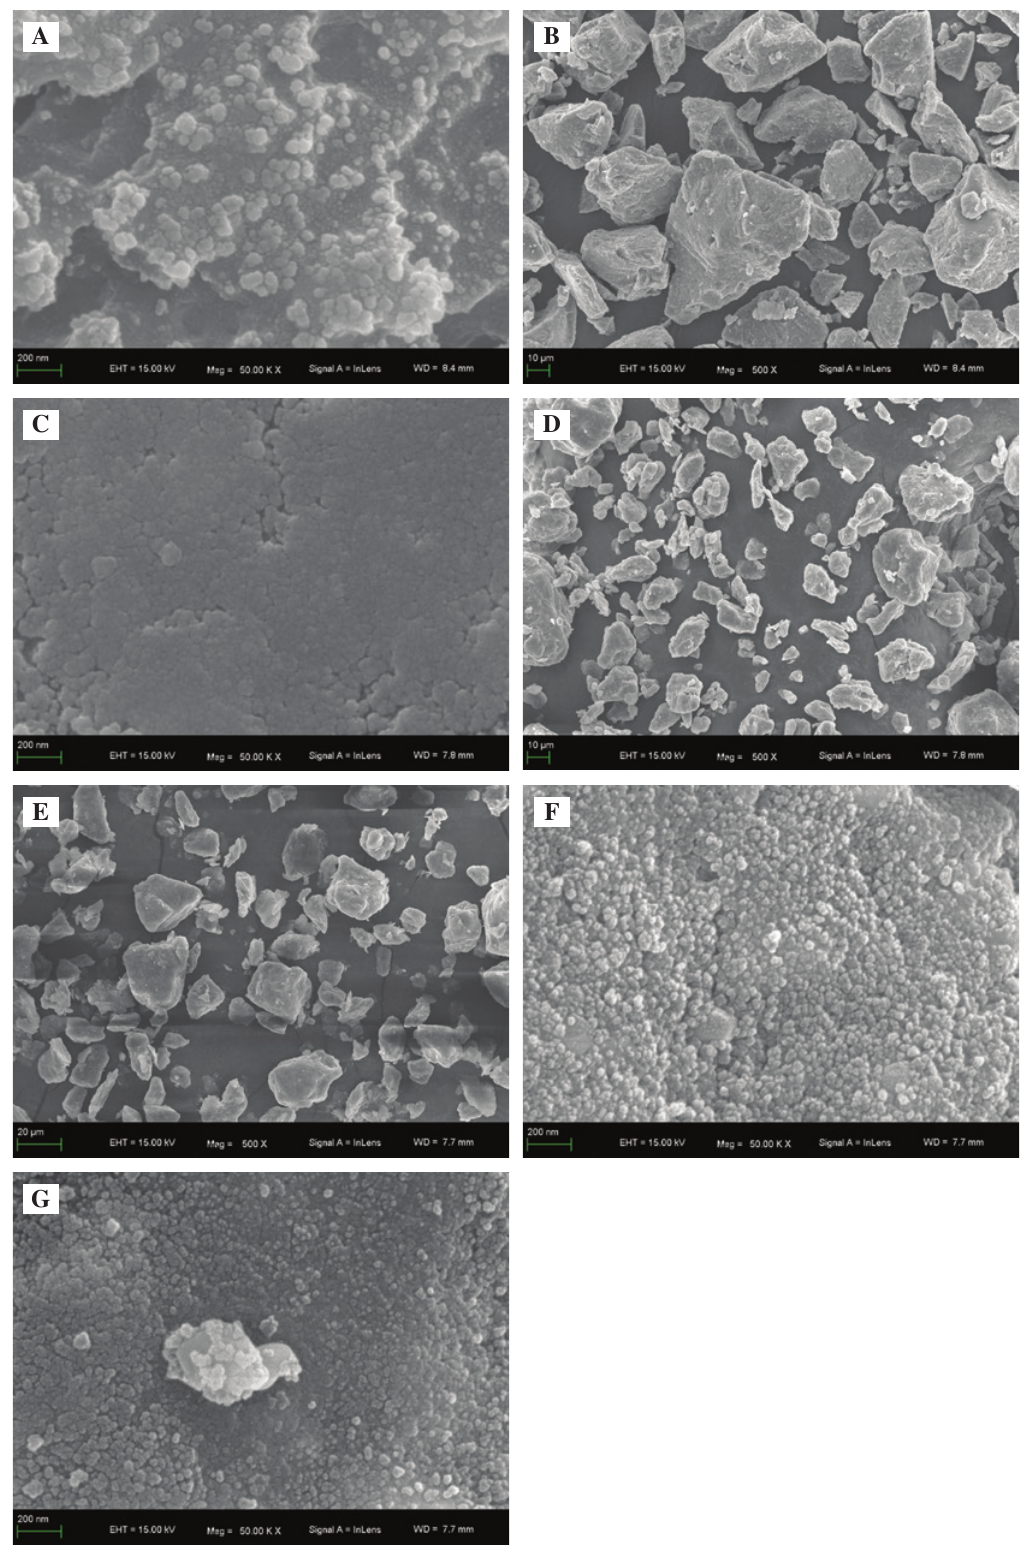
, (B and C) untreated pure PU, (D and F) 2 wt.% SiO 2